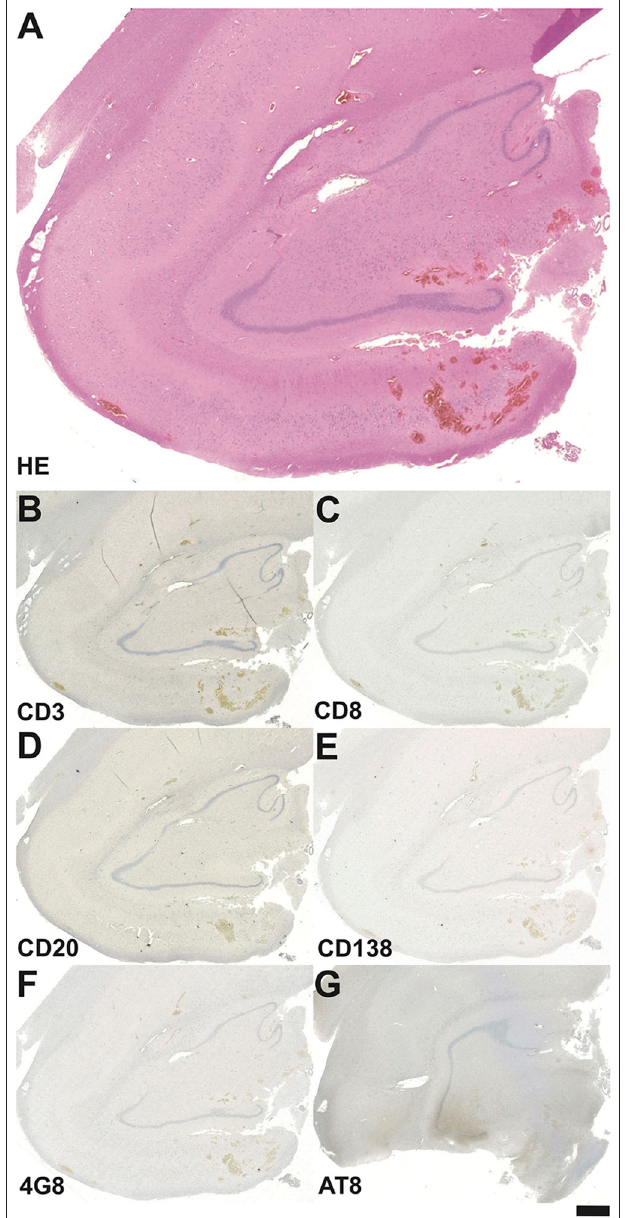
FIGURE 4 | Neuropathological findings in the hippocampal biopsy specimen in a patient from the control group operated on at the age of 33 years. (A) On the HE-stained section no definite signs of HS can be seen. Staining against the T-cell marker CD3 (B) , cytotoxic T-lymphocyte marker CD8 (C), the B-cell marker CD20 (D) and the plasma cell marker CD138 (E) do not reveal any inflammatory cell reaction. (F) Among neurodegenerative markers, there is no hint of 4G8-positive amyloid plaques, (G) AT-8 positive tau fibrils are missing as well. Bar graph corresponds to 500 µ m in A, and 1.0mm in B-G.